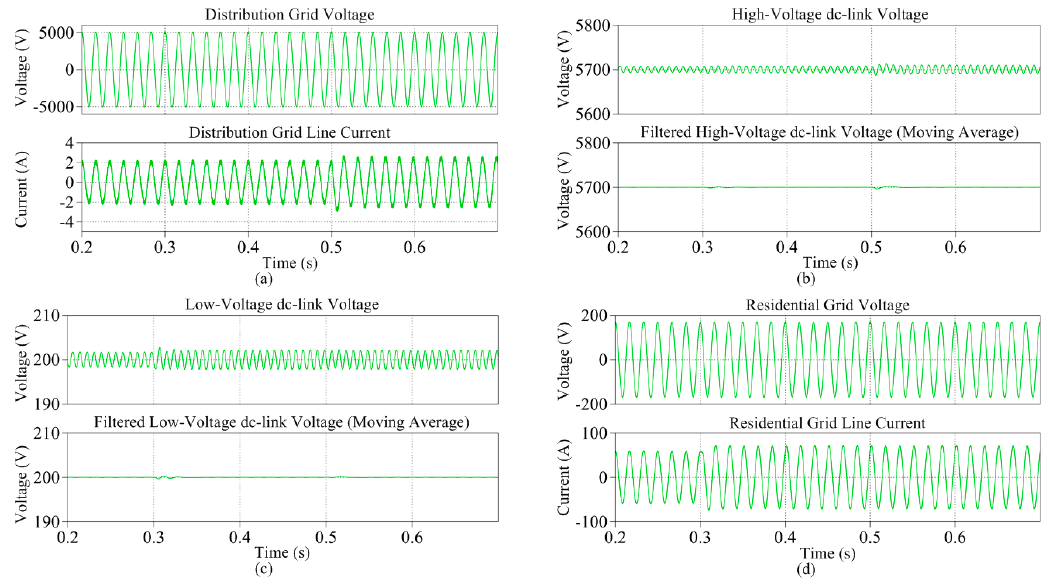
Figure 10. The major voltage and current waveforms in the various parts of the SST system under the reactive-power regulation scenario ( i d * = 59 A from 0 to 0.7 s, for the residential grid i q * = 39.3 A (lagging) from 0.3 s, and for the distribution grid i q * = − 1.3 A (leading) from 0.5 s); ( a ) Distribution grid voltage and current, ( b ) high-voltage-side dc-link voltage, ( c ) low-voltage-side dc-link voltage, ( d ) residential grid voltage and current.